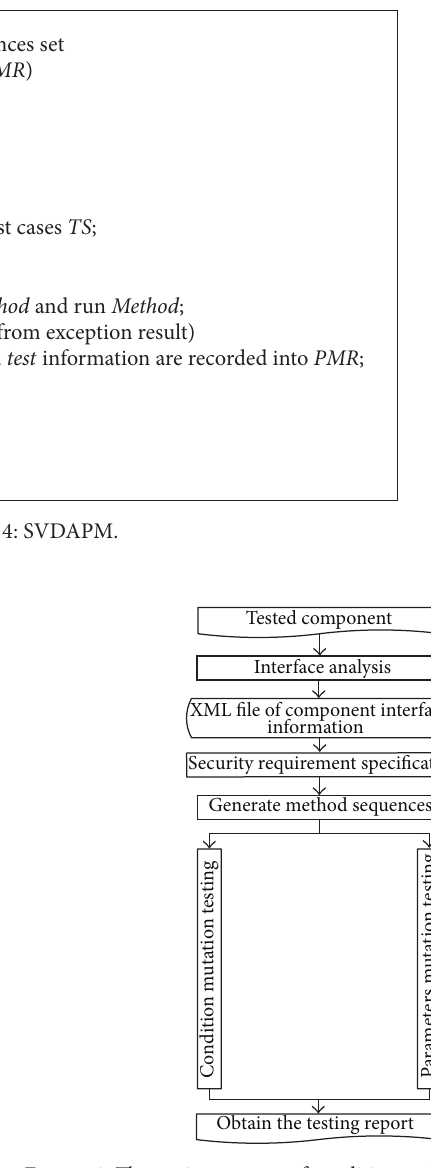
Figure 2: The testing process of condition and parameter